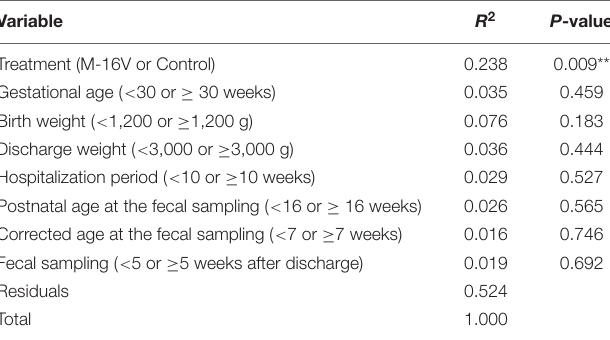
TABLE 3 | Multivariate analysis using PERMANOVA to test the variation in microbiota composition explained by each